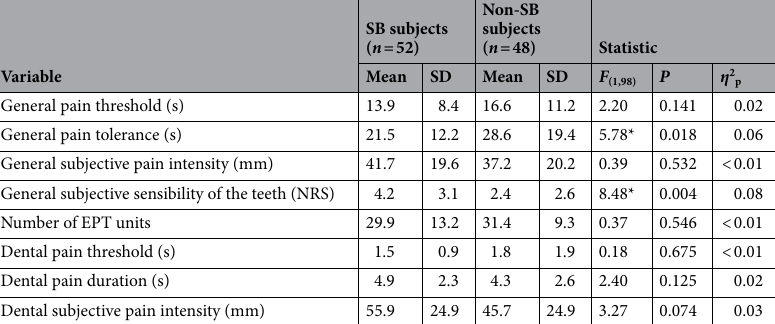
Table 3. Post-hoc univariate ANOVAs, comparing pain-related outcome between SB and non-SB subjects ( n = 100 a ). *Statistically significant comparisons ( p < 0.05). EPT Electric Pulp Test, NRS Numeric Rating Scale from zero to ten, SB sleep bruxism. a Missing data n = 5.